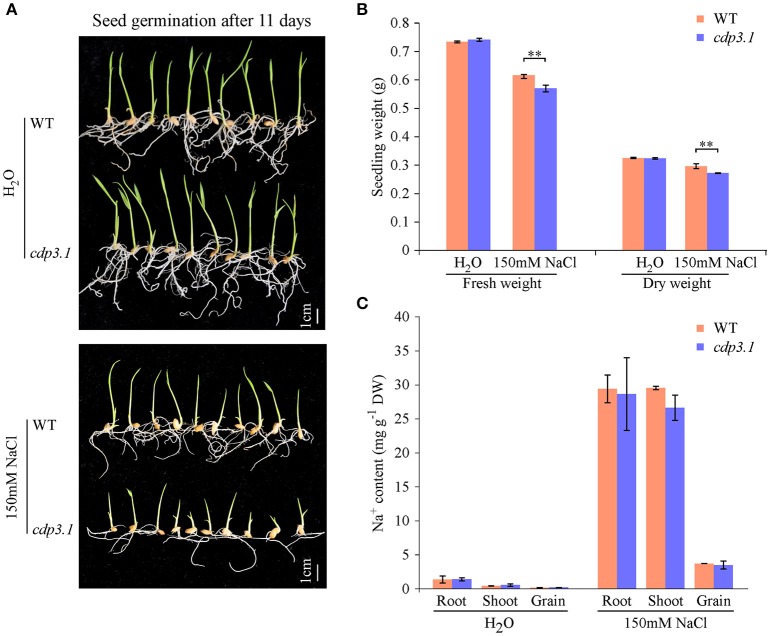
Comparison of seedling growth and Na+ ion accumulation in tissues between wide type (WT) and CDP3.1 mutant line (cdp3.1) under water and salt stress conditions. (A) Seedling growth of WT and cdp3.1 after 11 days under water and 150 mM NaCl conditions. (B) Fresh and dry seedling weight of WT and cdp3.1 after 11 days under water and 150 mM NaCl conditions. (C) Accumulation of Na+ in grains, roots, and shoots of WT and cdp3.1 after 11 days under water and 150 mM NaCl conditions. Each column represents means ± standard deviation. ** indicated the significant difference at 1% level.